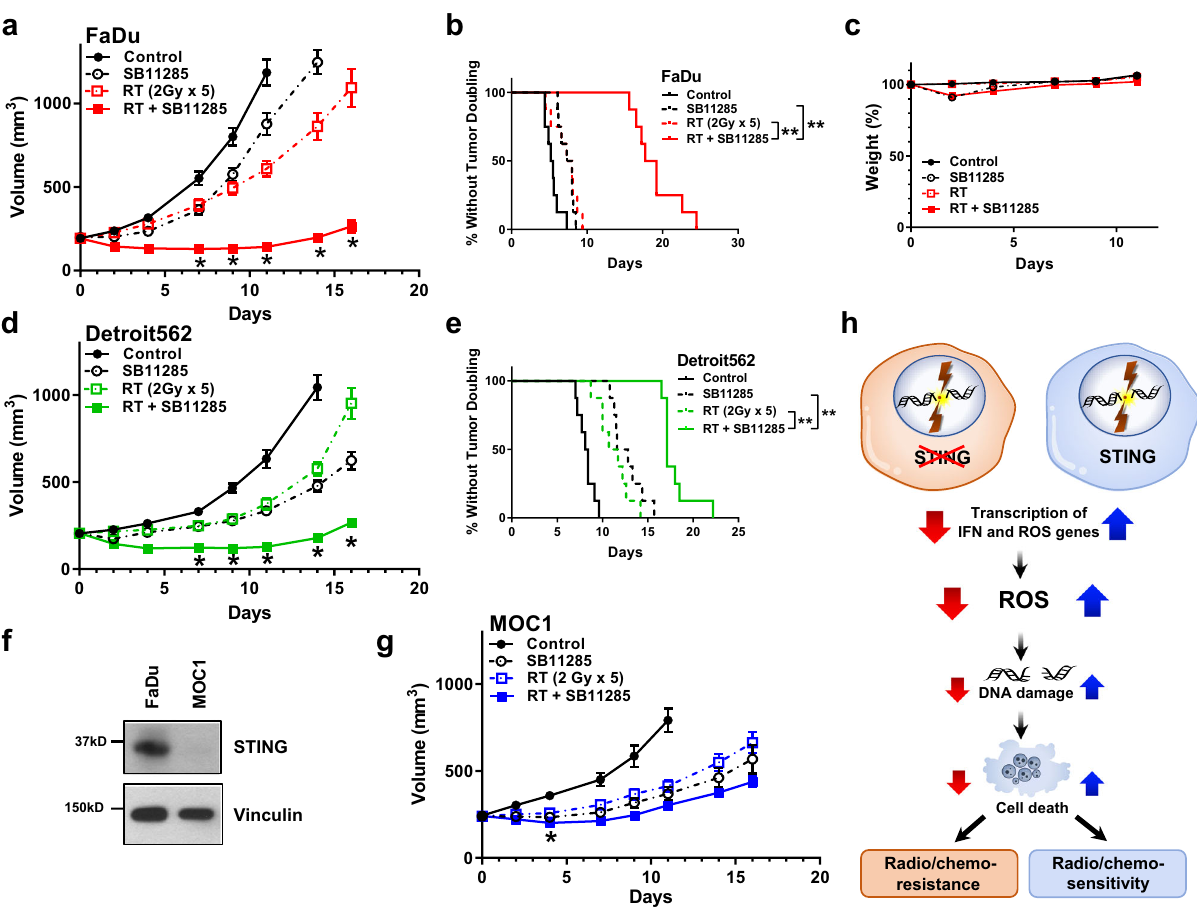
Fig. 6 Novel STING agonist SB11285 enhances in vivo response to radiation therapy. a FaDu tumor growth curves for each treatment group. Error bars represent the SEM of n = 8 mice per treatment group; * P -values for 7, 9, 11, 14, and 16 days are 0.0007, 0.0003, 0.0002, 0.0007, and 0.002 (RT + SBP11285 compared to RT) based on two-way ANOVA with Sidak post-hoc multiple comparison correction. b Kaplan – Meier curves of percent tumors without tumor doubling (400 mm 3 ). Statistical analysis was performed by log-rank testing ( n = 8 per treatment group), with ** P < 0.0001. c Weight as strati fi ed by treatment group ( n = 8 mice per group). d Detroit 562 growth curves for each treatment group. Error bars represent the SEM of n = 8 mice per treatment group; * P -values for 7, 9, 11, 14, and 16 days are 0.001, 0.002, 0.002, 0.0002, and 0.002 (RT + SBP11285 compared to RT) based on two- way ANOVA with Sidak post-hoc multiple comparison correction. e Kaplan – Meier curves of percent tumors without tumor doubling (400 mm 3 ). Statistical analysis was performed by log-rank testing ( n = 8 per treatment group), with ** P < 0.0001. f Western blots of STING expression in FaDu and MOC1 cells and are representative of two independent experiments. g MOC1 tumor growth curves for each treatment group. Error bars represent the SEM of n = 6 mice per treatment group; * P = 0.03 (RT + SBP11285 compared to RT) based on two-way ANOVA with Sidak post-hoc multiple comparison correction. h Proposed model of tumor intrinsic STING loss leading to treatment resistant